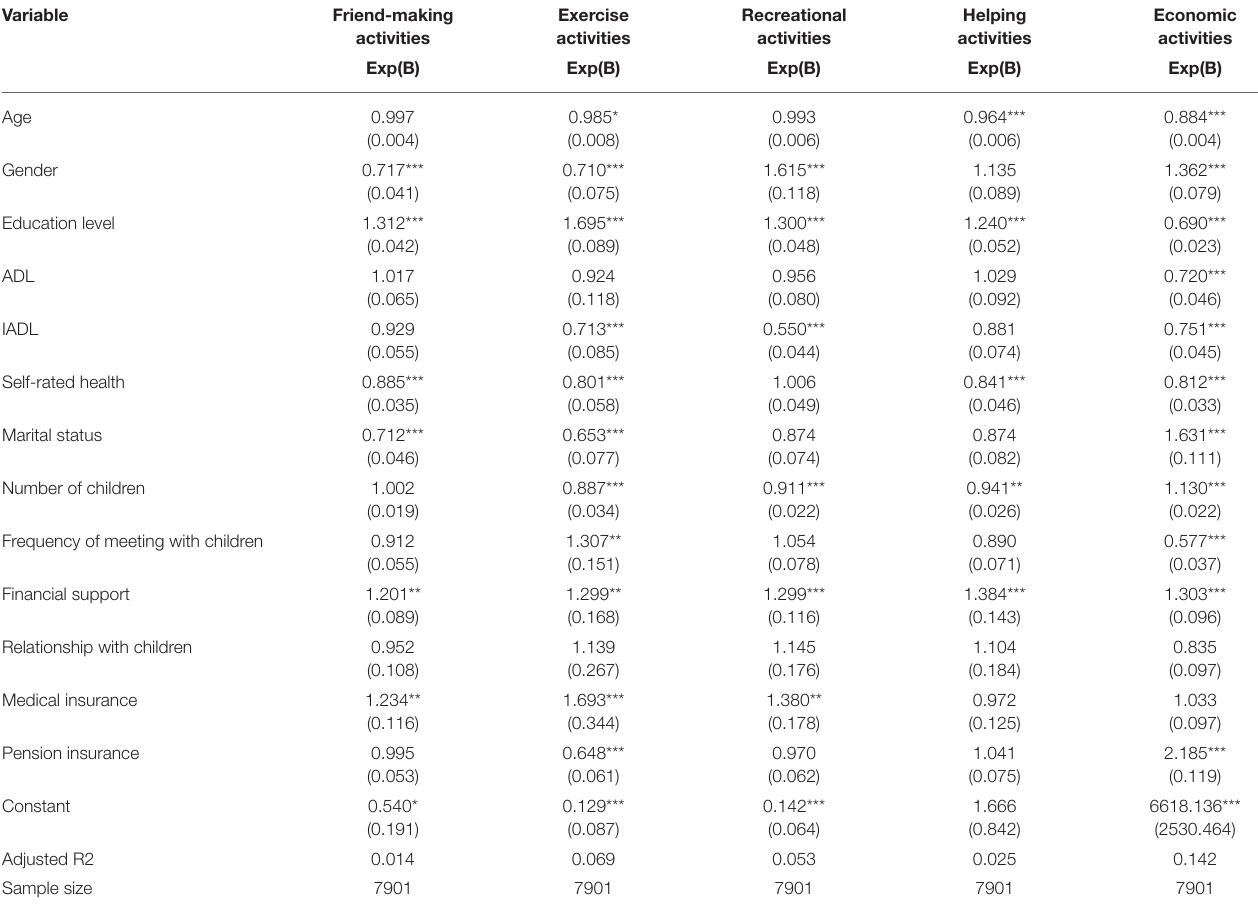
TABLE 4 | Logistic estimation results of five types of social